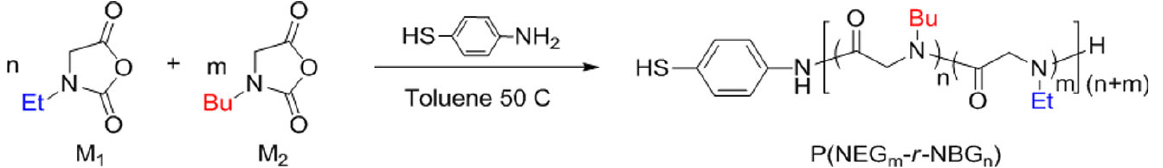
Figure 13. Copolymerization of N -Ethyl N -Carboxyanhydride and N -Butyl N -Carboxyanhydride with the initiator 4-Aminothiopheno (Adapted from ref. [86]. Copyright 2019, American Chemical Society).